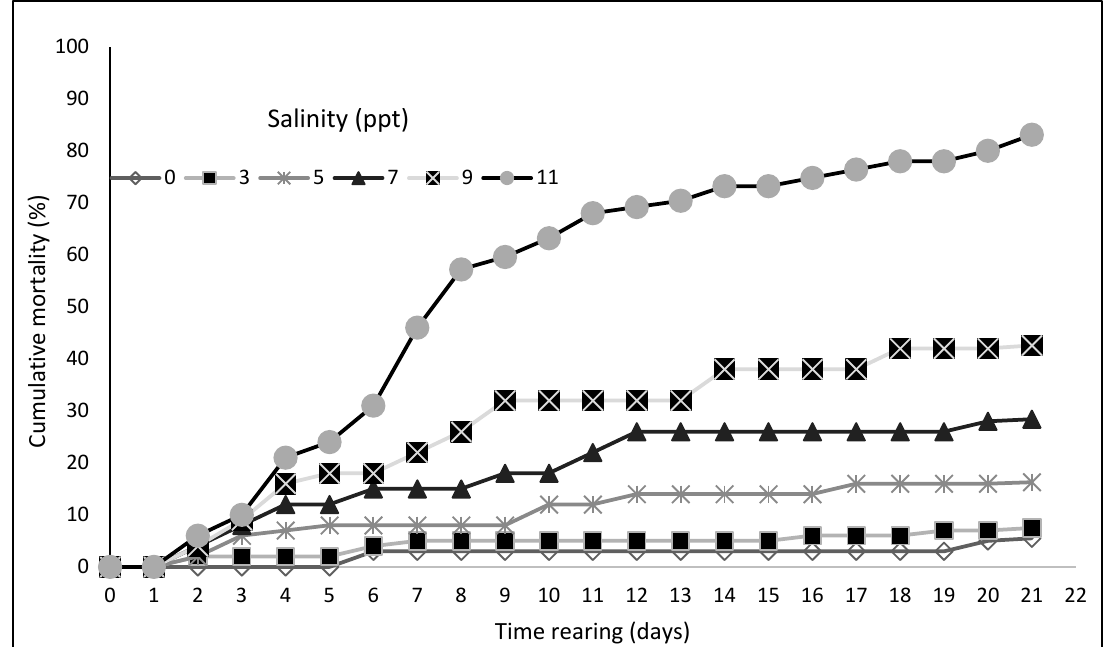
Figure 1. Cumulative mortality rate for asp larvae Leuciscus aspius (L.) reared in water with various salinity levels.